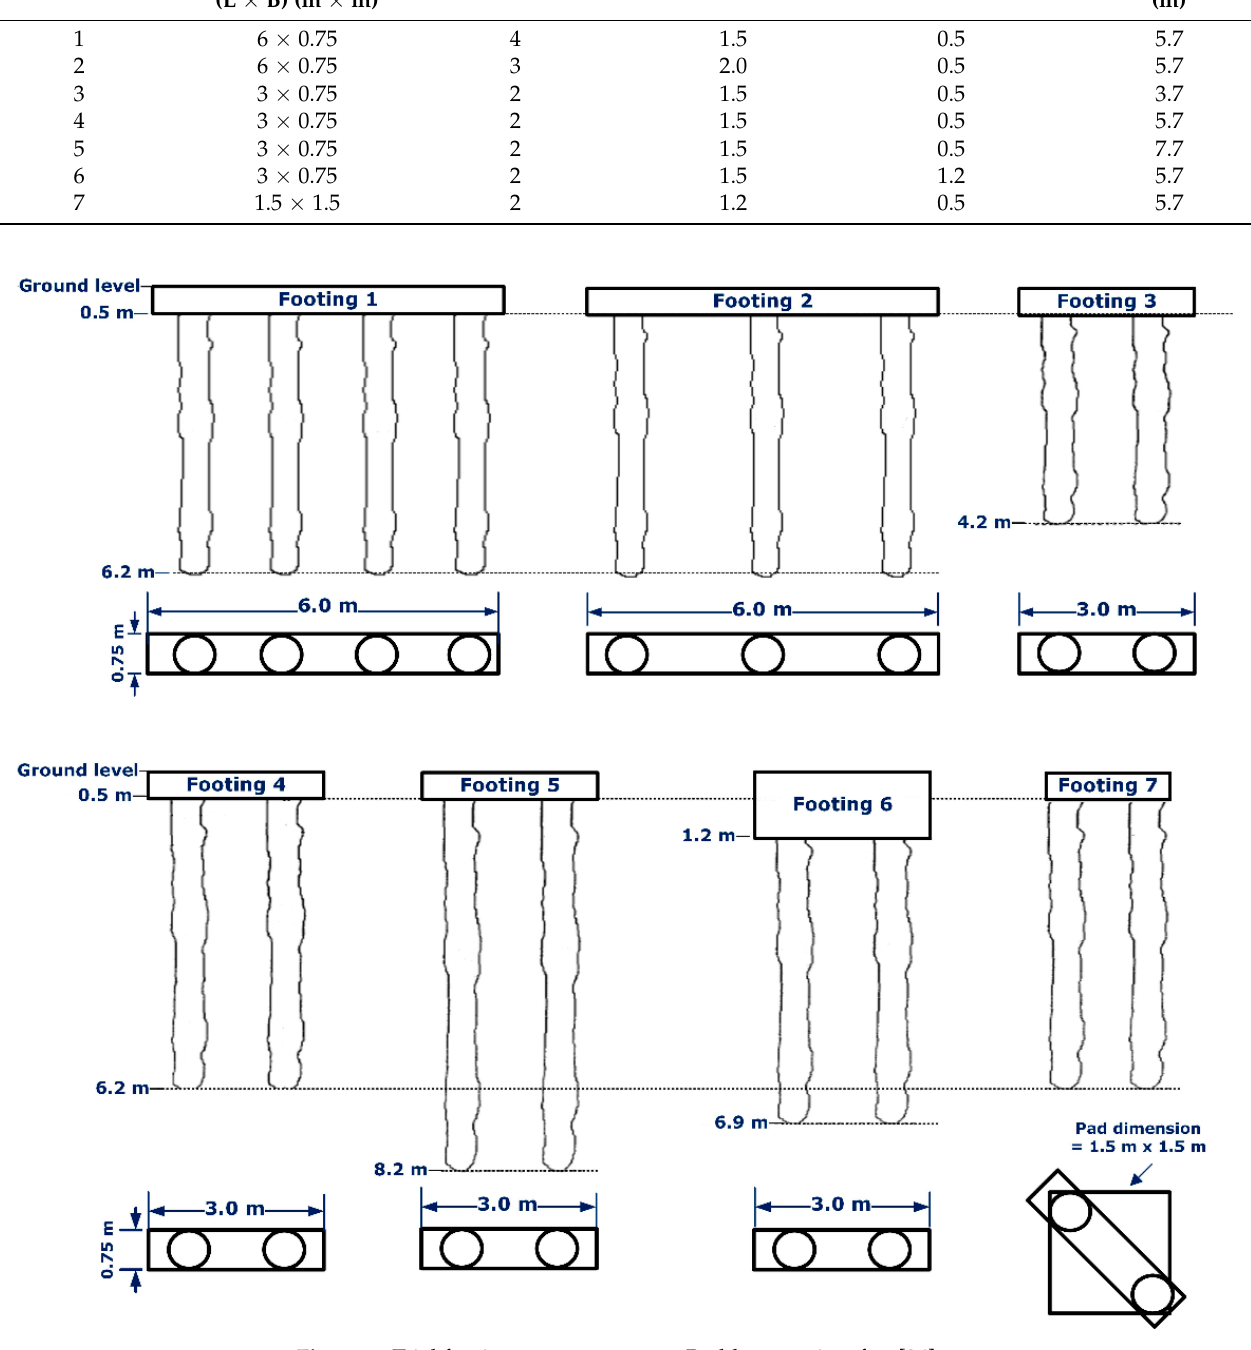
Figure 2. Trial footing arrangements at Bothkennar site after [36]. The stone columns are generally one order of magnitude stiffer than the surrounding weak soil and will attract a greater proportion of the load compared to the surrounding soft soil as defined by [12]: